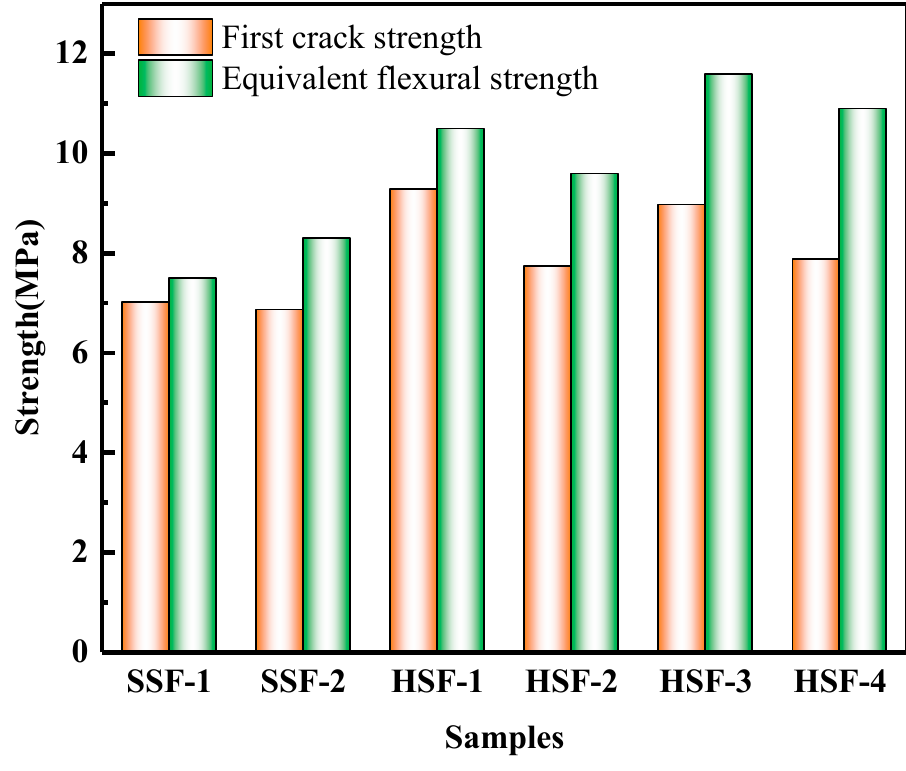
Figure 7. Different strengths of FRC.